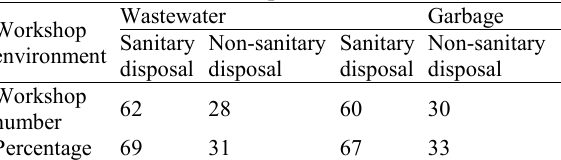
Table 2. Status of waste disposal and